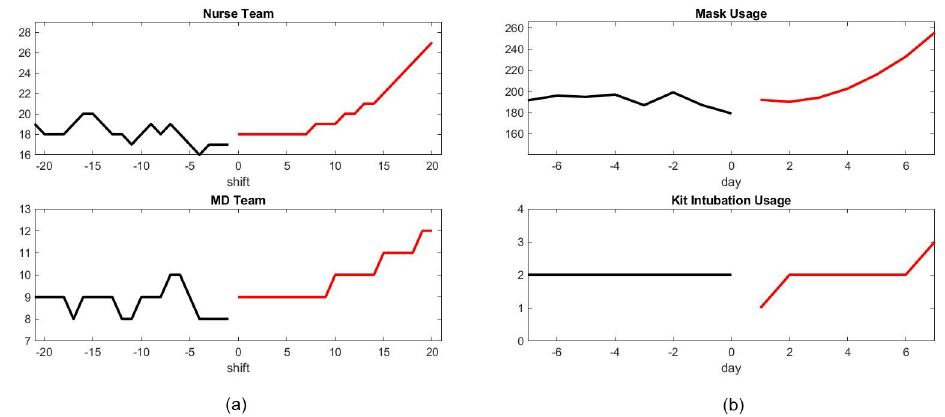
Fig 11. Prediction of infrastructure need in Scenario 1. (a) Number of staff needed for each 8 hours shift. (b) Number of supplies needed for each day.